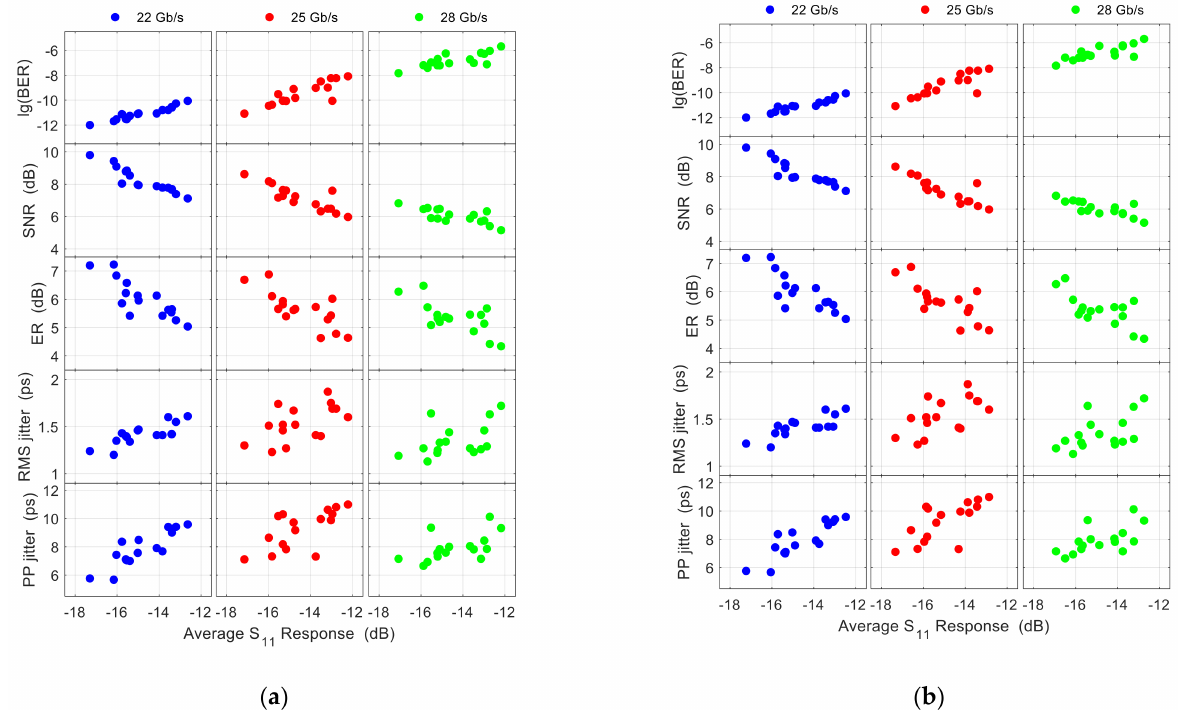
Figure 5. Relations between the bit error rate (BER), signal-to-noise ratio (SNR), extinction ratio (ER), root-mean-square (RMS) jitter, peak-to-peak (PP) jitter and the average of the S 11 response over the frequency range of ( a ) 0.75 times the data rate and ( b ) equal to the data